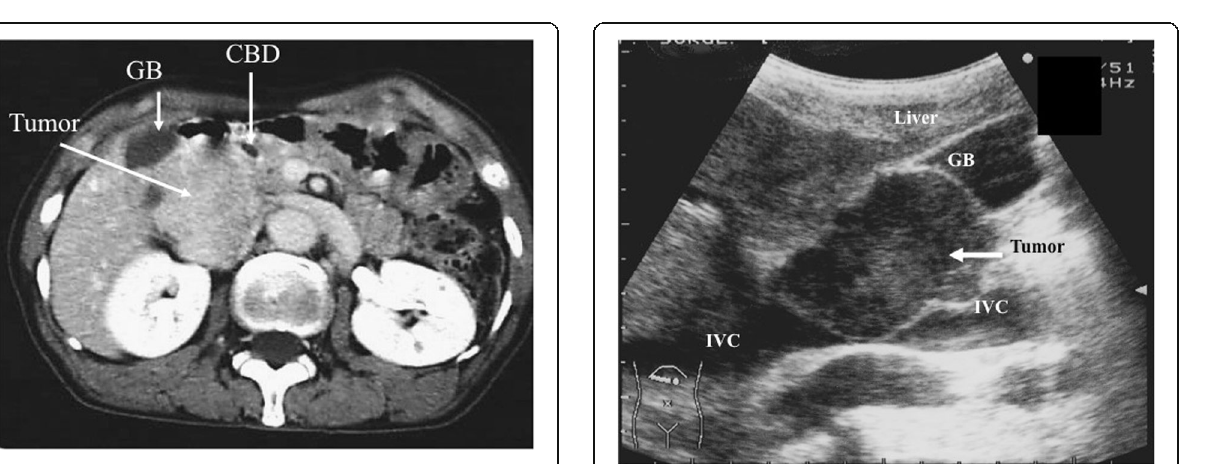
Fig. 3 Abdominal ultrasonography. Abdominal ultrasonography revealed an abnormal mass in the infrahepatic portion, which compressed the gall bladder and liver. GB gall bladder, IVC